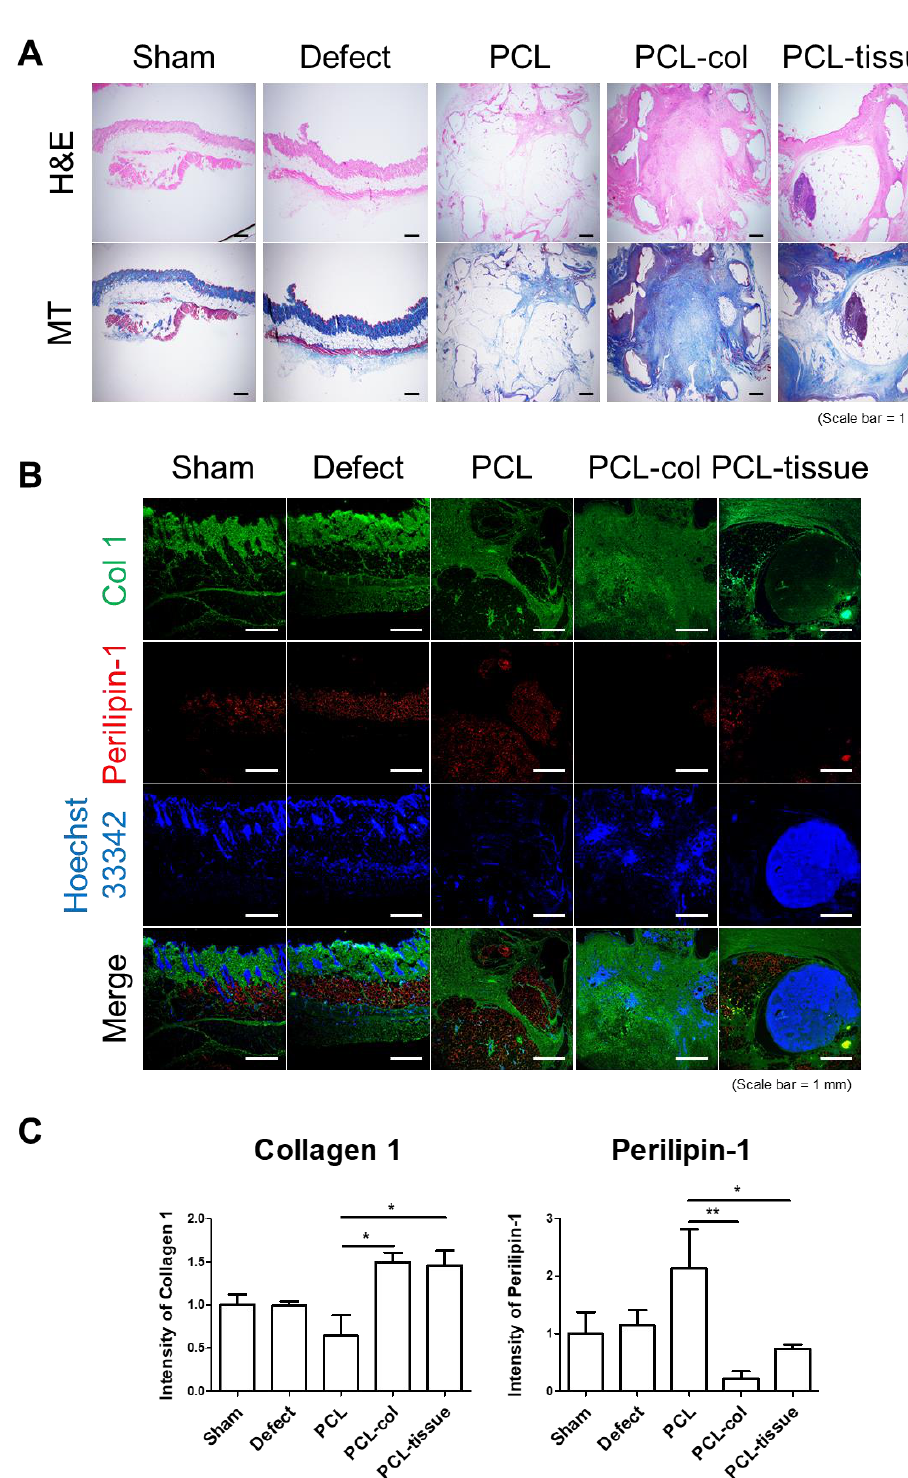
Figure 3. Histological analysis after implantation of the PCL scaffold in rat. ( A ) H&E and MT staining after PCL scaffold implantation; ( B ) Immunofluorescence analysis of collagen Type 1 (green) and perilipin-1 (red) and Hoechst 33342 counterstaining (blue) after PCL scaffold implantation; ( C ) Quantitative analysis of the intensity of collagen Type 1 and perilipin-1 (* p < 0.05, ** p < 0.01) (Scale bar = 1 mm).